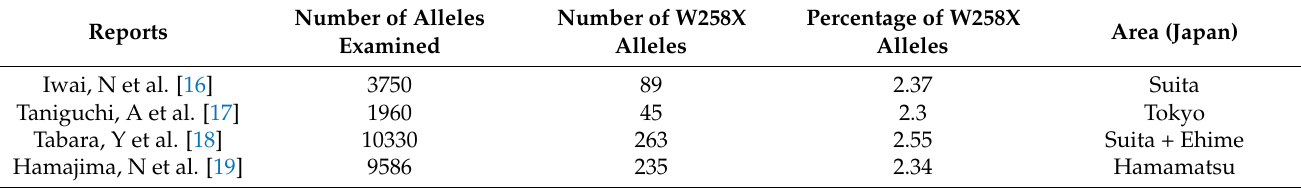
Table 1. Allele frequencies of URAT1 W258X in Japanese populations.